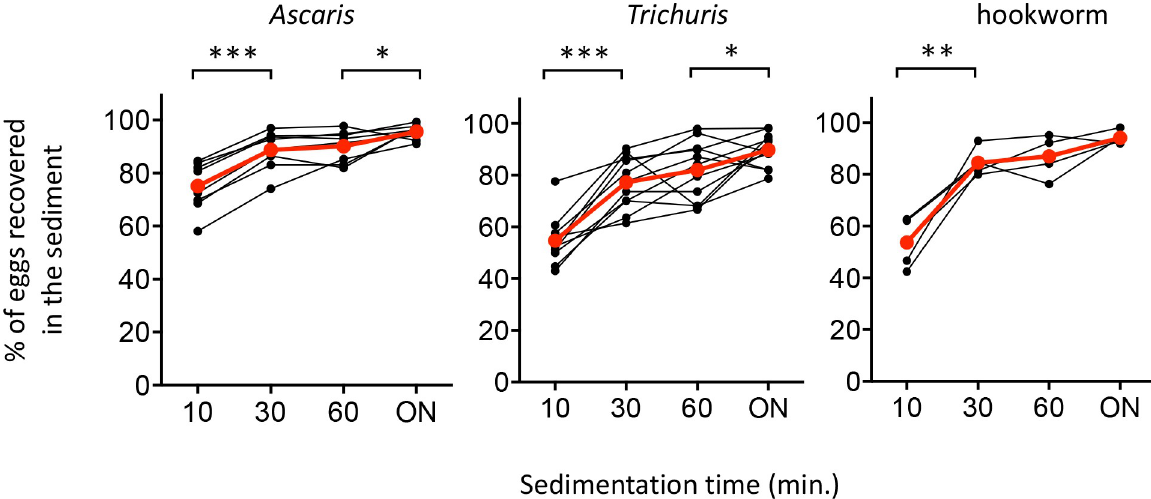
Fig 5. Line plots representing the percentage of STH eggs recovered in the slurry of the sedimenter at different sedimentation times (10, 30, 60 minutes and overnight (ON)). The average recovery percentage over the different samples is indicated in red. Significant increases in egg recovery percentages between subsequent sedimentation times are indicated ( � P < 0.05; �� P < 0.01, ��� P <